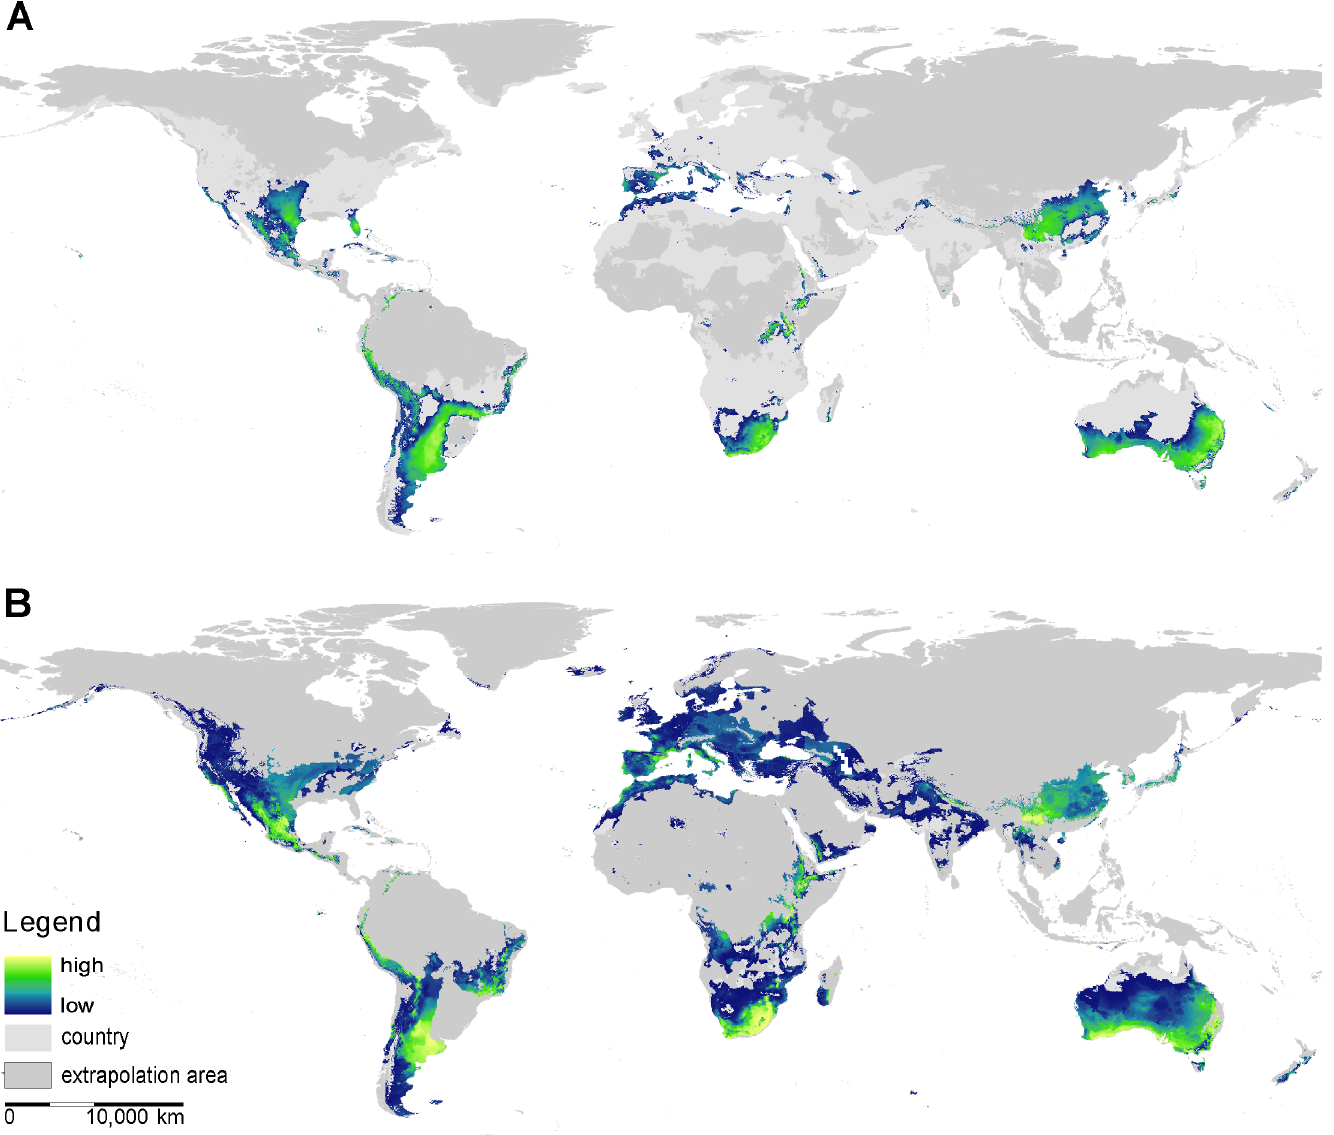
Fig 1. Global projection of the potential distribution of X . laevis A) derived from the maximum entropy SDM; B) derived from the ensemble SDM. Probability ranging from moderate (dark blue) to highly suitable